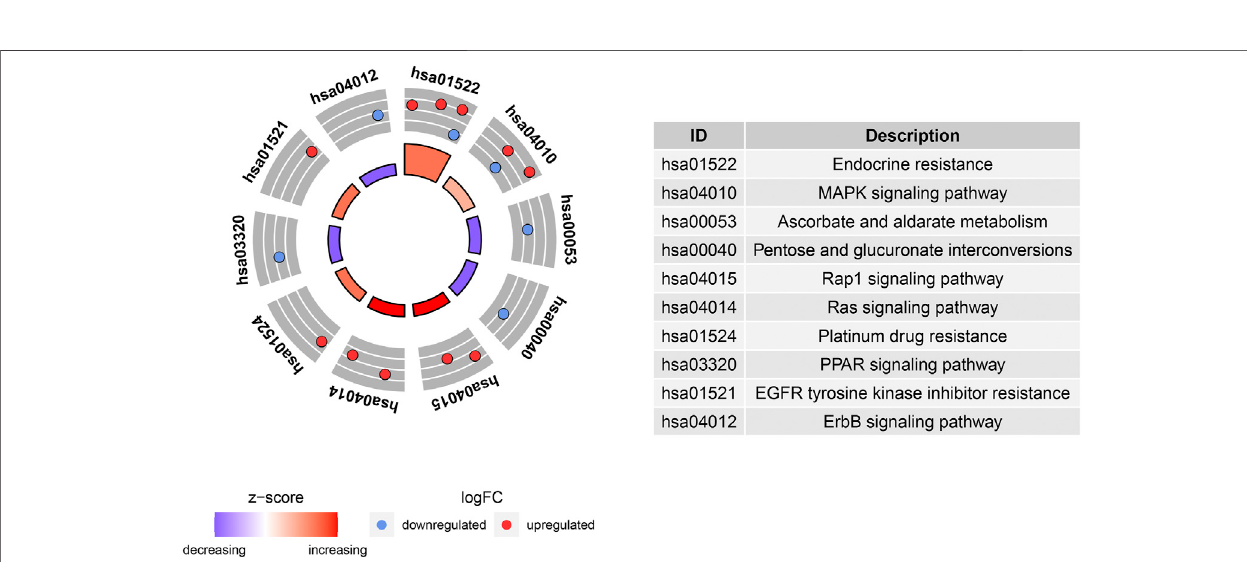
Frontiers in Genetics | www.frontiersin.org February 2022 | Volume 13 | Article 780010